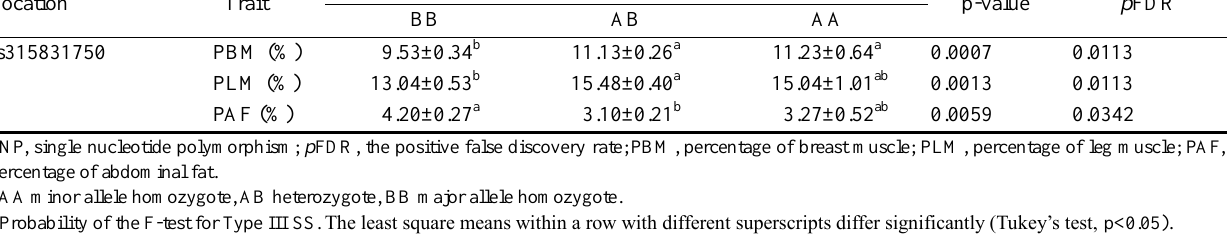
H3H7 chickens had greater PEW and H2H2 greater PLM than other diplotypes, and those with diplotype H7H7 had less PEW and PBM than other diplotypes (Table 6). Table 5. Haplotypes constructed with single nucleotide polymorphisms (SNP) and their frequencies The linkage disequilibrium analysis between the three SNP single nucleotide polymorphisms Haplotype The pattern of pairwise LD structure as measured by D' and r 2 between the SNPs was calculated using the program Haploview 4.1, and the haploblock structure presented in Figure 2. We performed LD and haplotype analysis for the three SNPs in all chickens, except for HB chickens. According to the data, the D' value between SNP1 and SNP2, SNP2 and SNP3, and SNP1 and SNP3 were 0.81, 0.92, and 0.66, respectively. Moreover, r 2 for them were 0.601, 0.539, and 0.309, respectively.